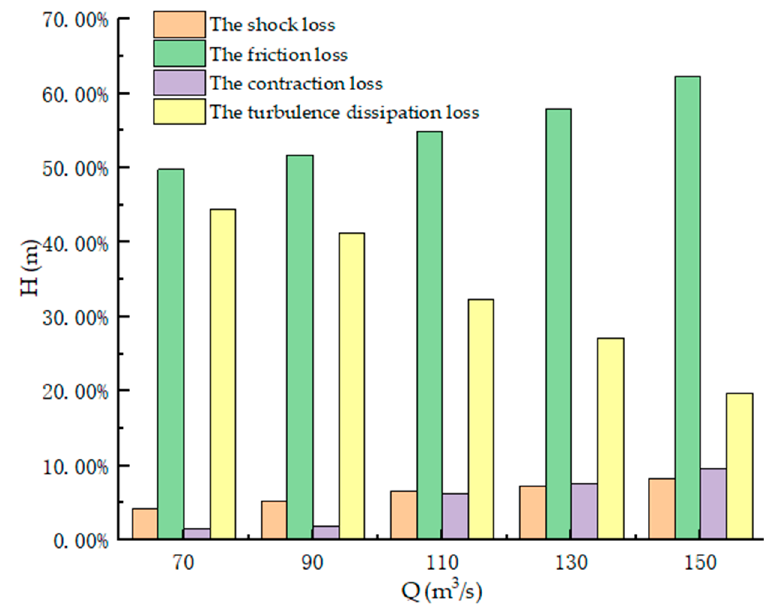
Figure 19. The proportion of each energy loss in the static impeller at different flow rate.